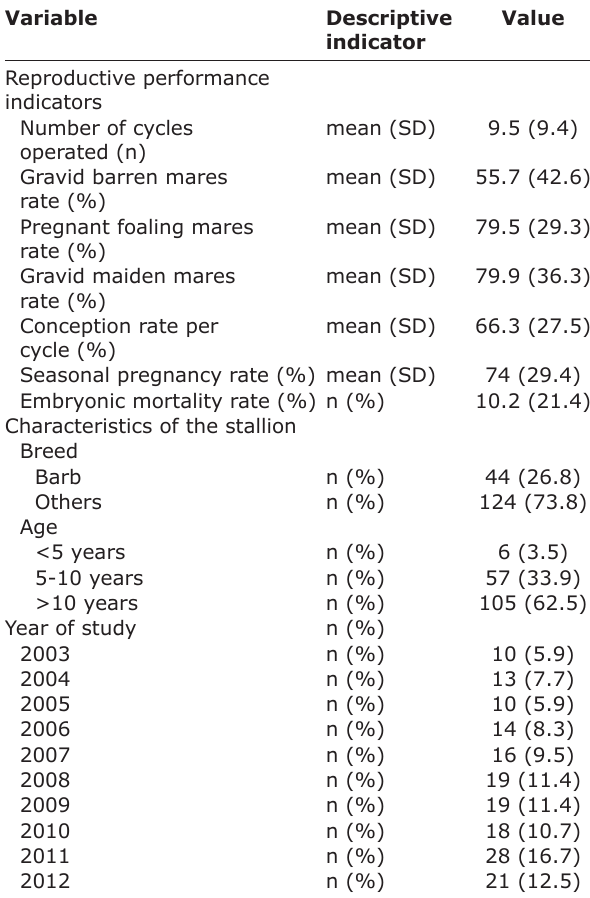
Table-1: Results of descriptive analysis of the reproductive performance indicators and characteristics of the stallion (sample